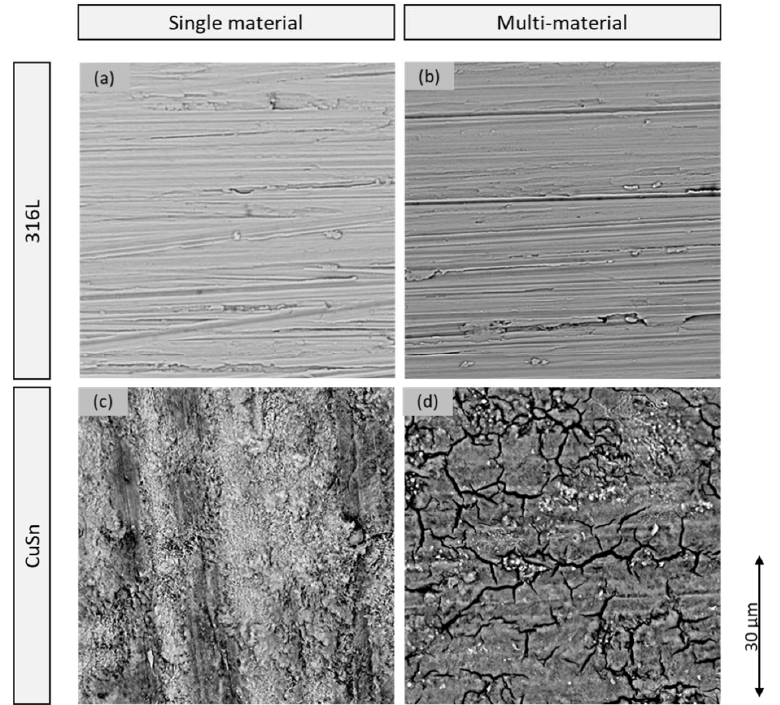
Figure 9. Surfaces after the LSV test under the scanning electron microscope ( a ) 316L-AM-A; ( b ) 316L/CuSn-AM steel side; ( c ) CuSn-AM-A; ( d ) 316L/CuSn-AM bronze